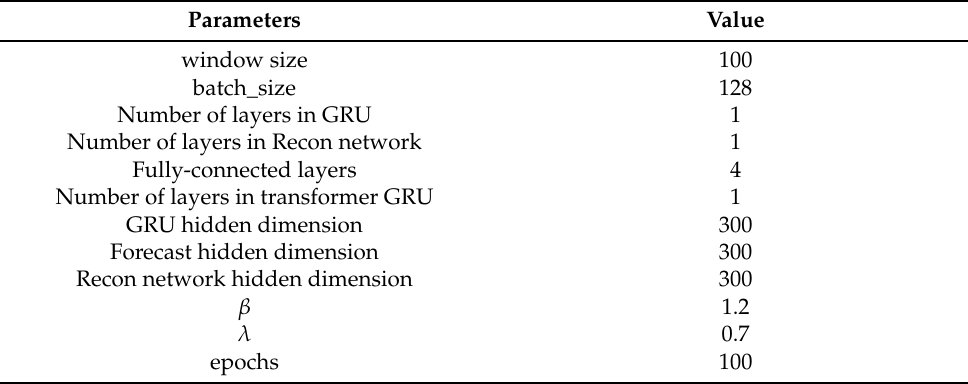
Table 2. Parameter